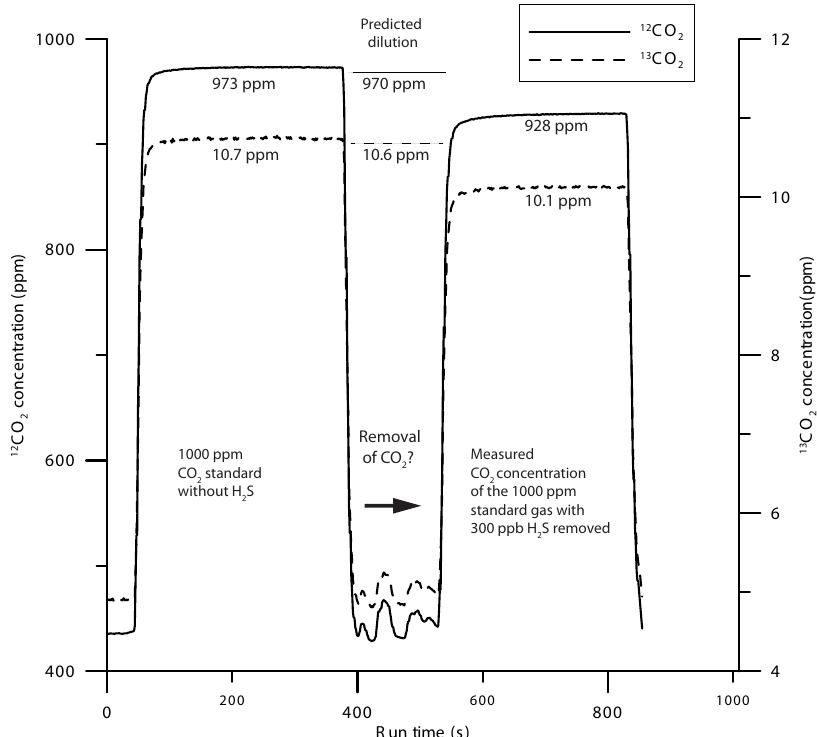
Figure 4. The addition of 3mL of 100ppm H 2 S to 1L of the 1000ppm standard gas resulted in a large drop in 12 CO 2 and 13 CO 2 concen- trations. The observed concentrations are significantly lower than those predicted to result from dilution of the standard gas with the addition of 3mL of H 2 S. When the copper scrub removed H 2 S, the CO 2 concentration remained anomalously low. It is likely that a reaction between H 2 S and CO 2 removes a portion of the CO 2 from the mixture before it is